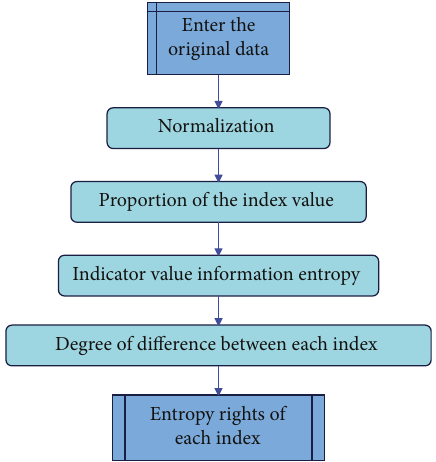
Figure 1: Entropy weight method